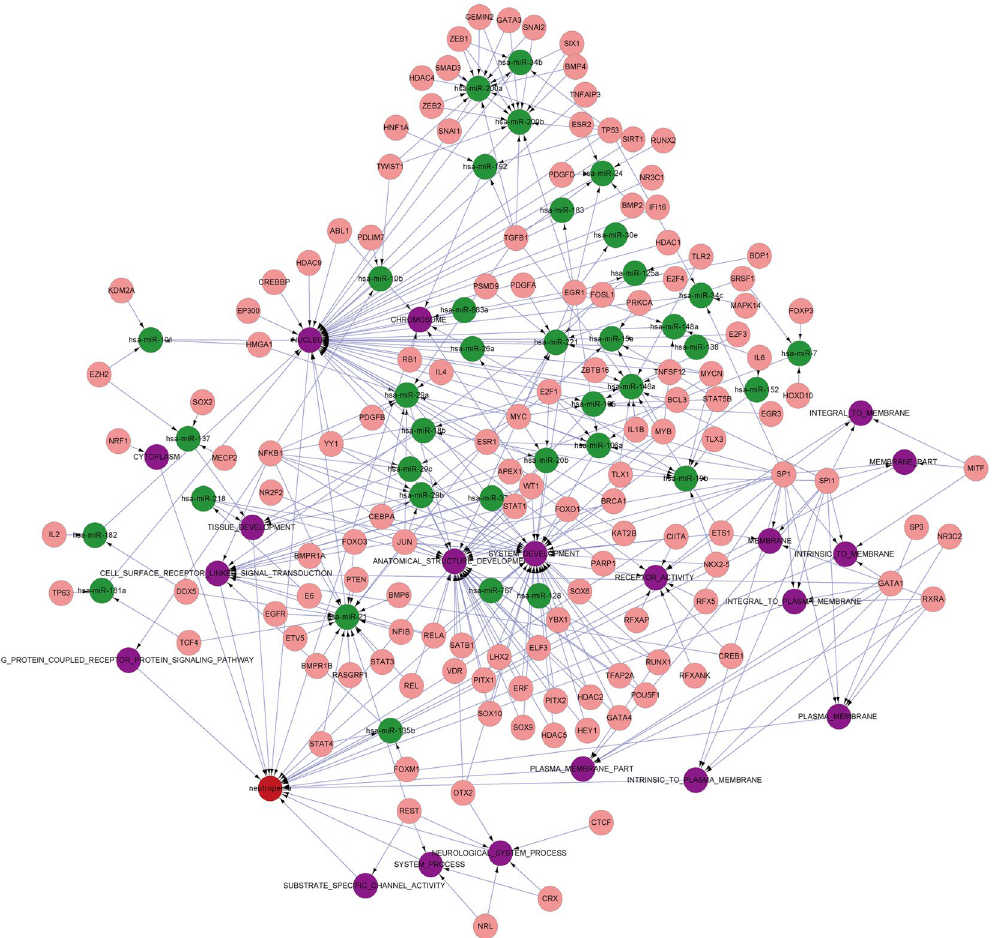
Figure 7. The complex regulatory module of Neutropenia. The red nodes represent side effects, the purple nodes represent gene sets, the green nodes represent miRNAs and the pink nodes represent TFs. Neutropenia, with 20 sets of genes regulated by miRNAs and